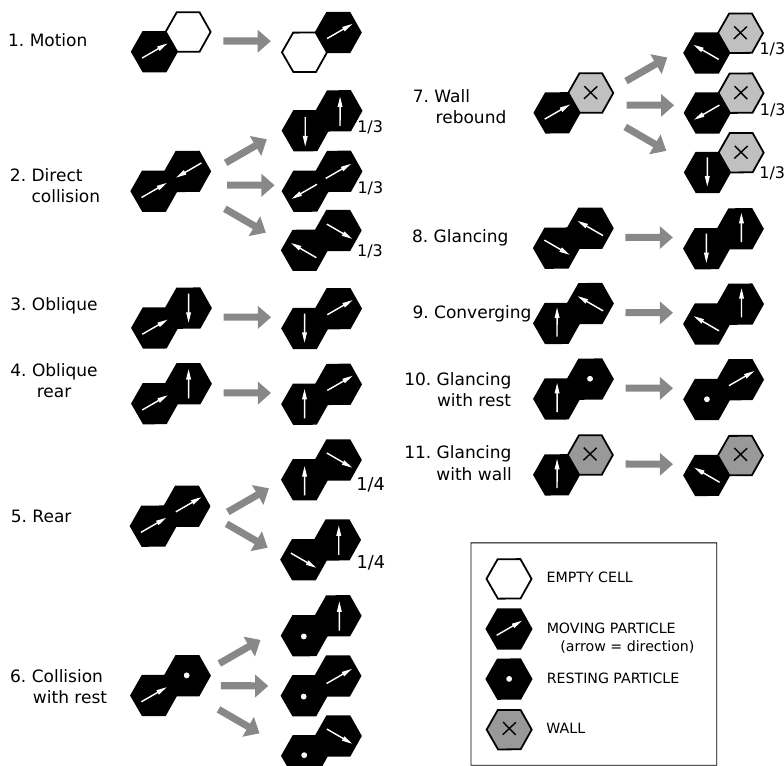
Figure 11. Motion and collision rules for a pairwise CTS lattice gas model. For states that have multiple transitions, the transition rate for each is reduced from unity to the fraction shown. Reduction to a one-fourth rate (instead of one-half) for rear collisions accounts for the possibility that the lead particle is faster (so no collision